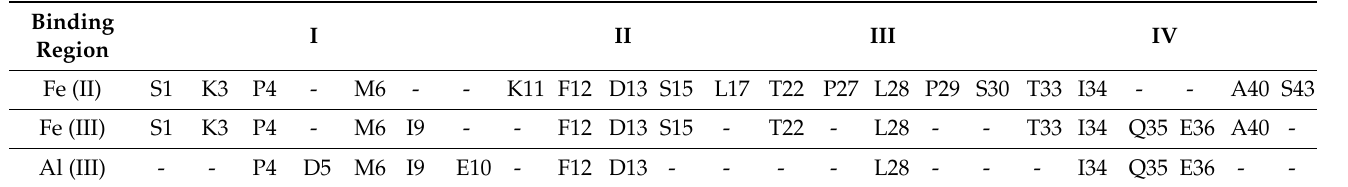
Table 1. Amino acid residues affected by metal/peptide interactions. Metal-binding regions are also signed in Scheme